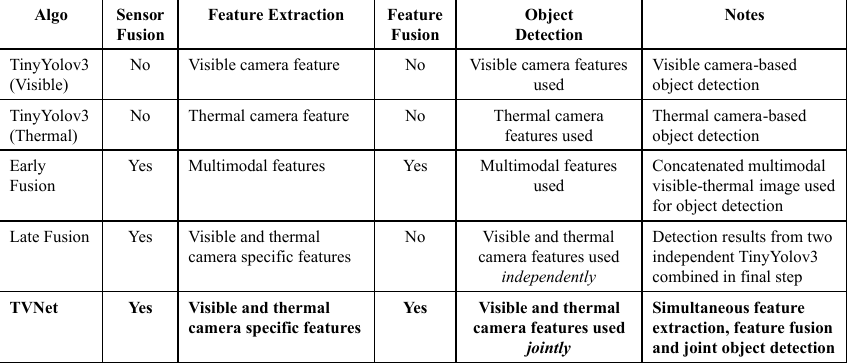
Figure 7. TVNet compared with the baseline algorithms. Contributions to literature highlighted.